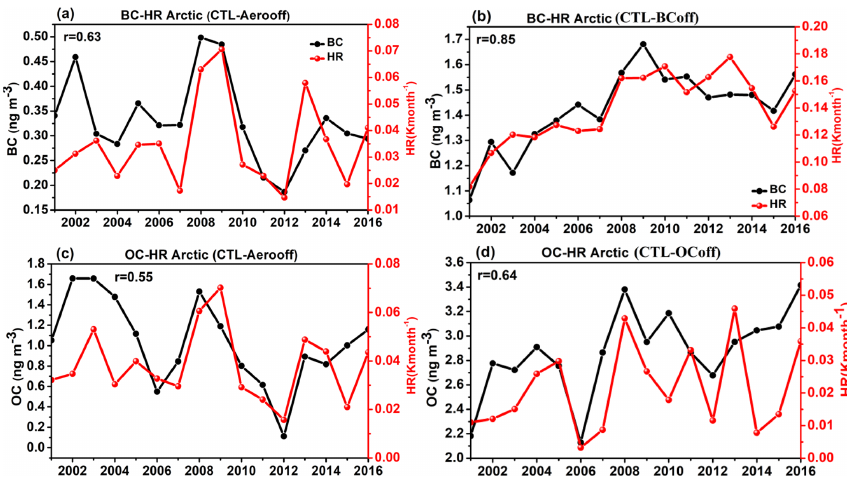
Figure 9. (a) Time series of BC aerosols and heating rates averaged for spring in the UTLS (380K) in the Arctic (65–85 ◦ N, 0–360 ◦ ) (from CTL-Aerooff). (b) Same as (a) but from CTL-BCoff. (c) Same as (a) but for OC. (d) Same as (c) but from CTL-OCoff. The correlation coefficient ( r ) between anomalies of BC / OC aerosols and heating rates is indicated in (a–d)